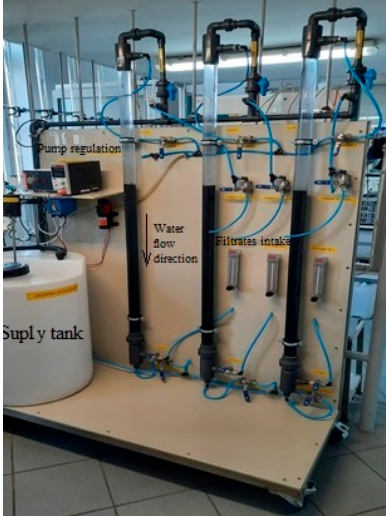
Figure 1. Installation used to implement the adsorption process.